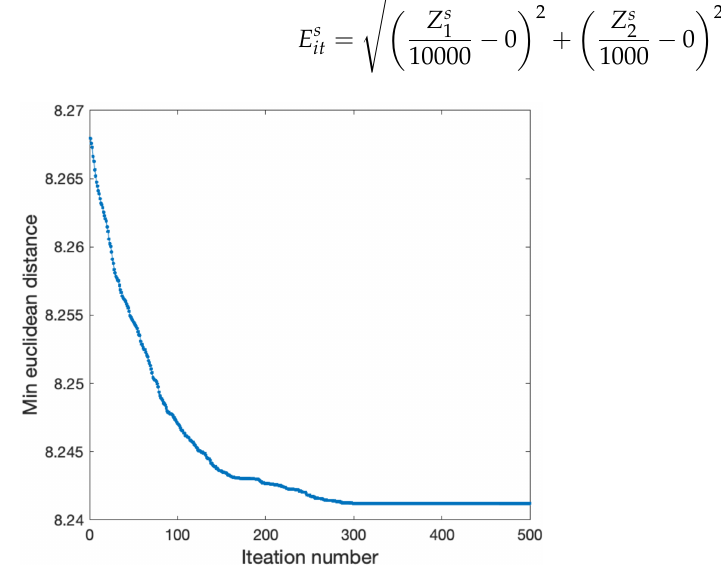
Figure 12. Minimum Euclidean distance changes with the number of